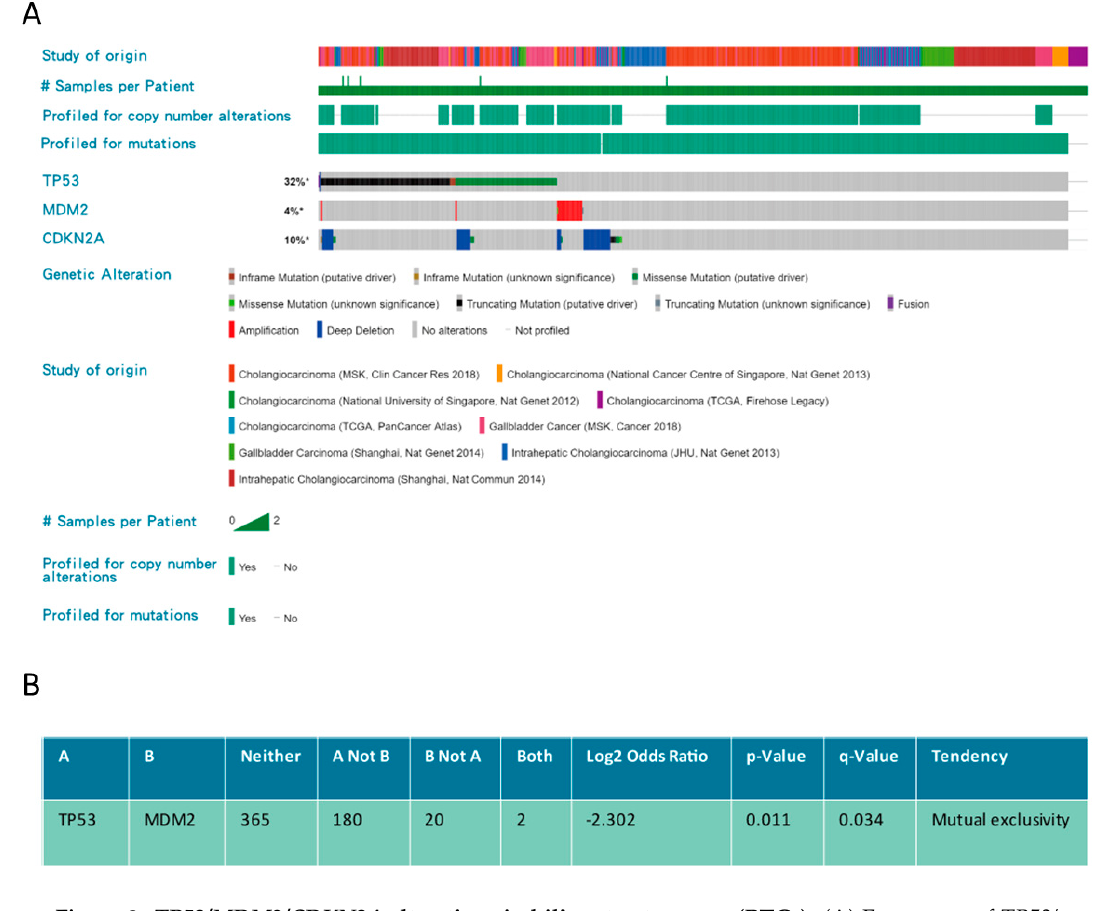
Figure 3. TP53 / MDM2 / CDKN2A alterations in biliary tract cancers (BTCs). ( A ) Frequency of TP53 / Figure 3. TP53/MDM2/CDKN2A alterations in biliary tract cancers (BTCs). ( A ) Frequency of MDM2 / CDKN2A alterations in di ff erent studies. ( B ) The association between TP53 / MDM2 / TP53/MDM2/CDKN2A alterations in different studies. ( B ) The association between TP53/MDM2/CDKN2A alterations. Data were accessed at cBioPortal on 3 September 2020.